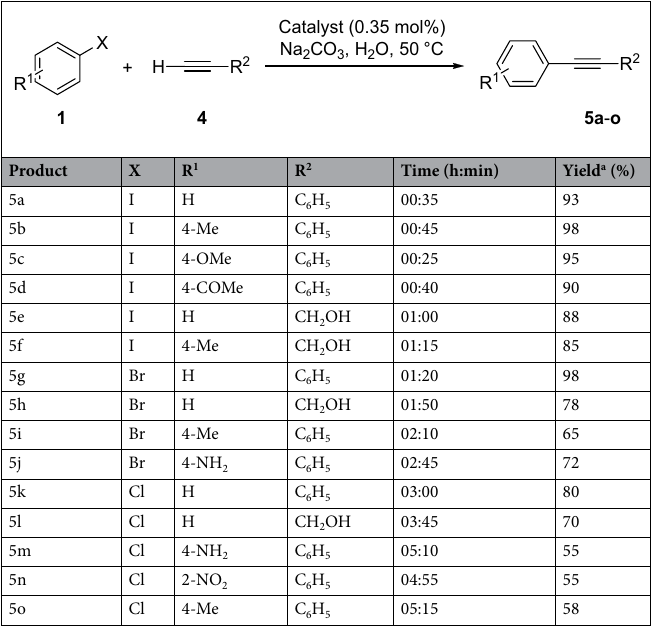
Table 2. Pd@h-Fe 2 O 3 @C catalyzed Sonogashira reaction of various aryl halides with terminal alkynes. Reaction condition: aryl halides (1.0 mmol), terminal alkynes (1.2 mmol), Pd@h-Fe 2 O 3 @C (0.35